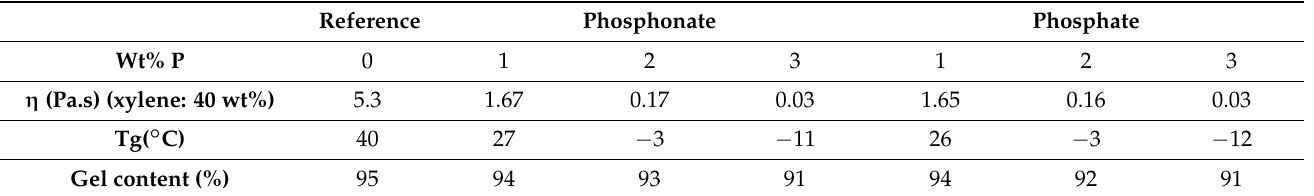
Table 2. Viscosity, Tg and gel content of phosphorylated cardanol reactive diluent alkyd resins with a fixed NVC at 60